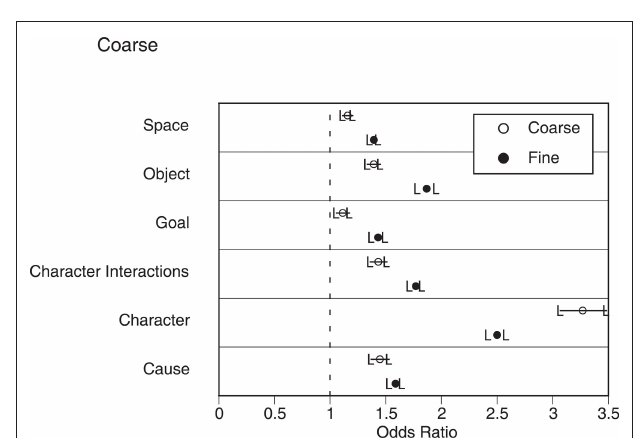
FIGuRE 2 | The relations between situation changes and segmentation in narrative film. Circles represent the odds ratios for the mean coefficients in the logistic regressions, and error bars represent the 95% confidence intervals for these odds ratios. Values whose confidence intervals do not include 1.0 (dashed lines) indicate a statistically significant relationship between changes on that dimension and segmentation.